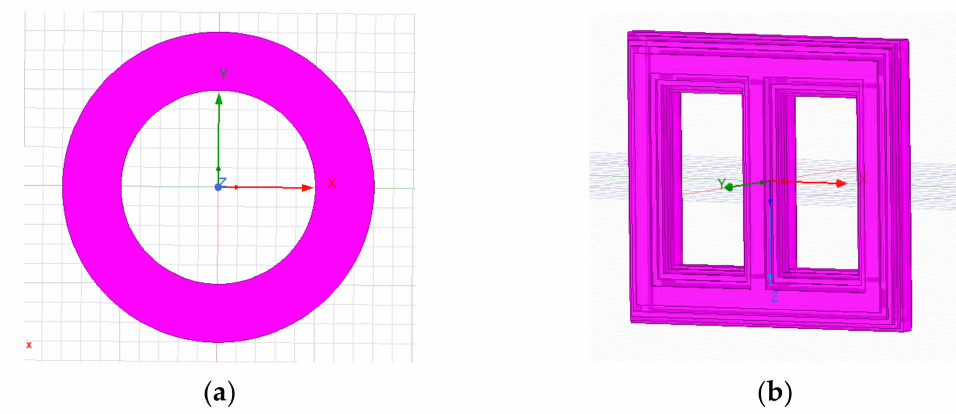
Figure 3. Core shapes: ( a ) Toroidal Core ( b ) Shell-Type